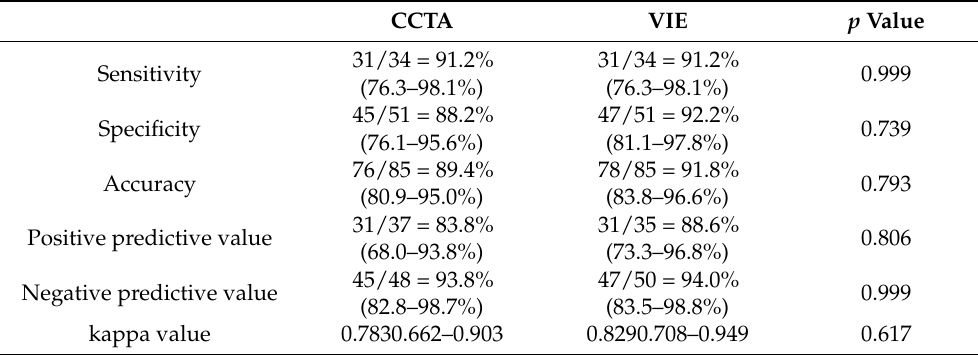
Table 4. Diagnostic performance of CCTA versus VIE in detecting coronary artery disease in 85 vessel segments with mixed plaques, using ICA as the gold